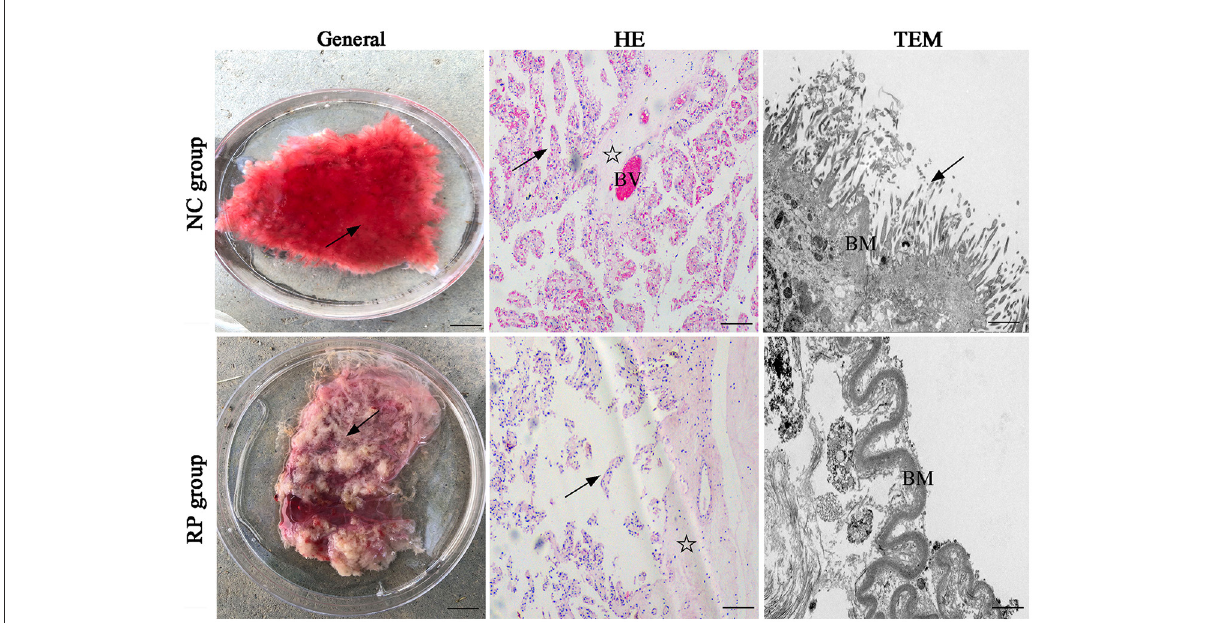
FIGURE1 General and pathological differences in the NC and RP groups. General images: scale bar represents 1cm; HE-stained images: scale bar represents 100 µ m; TEM images: scale bar represents 5 µ m. Villi (arrow), matrix (asterisk), blood vessel (BV), basement membrane (BM). NC, fetal membranes of normal discharge; RP, retained placenta; HE, hematoxylin-eosin; TEM, transmission electron